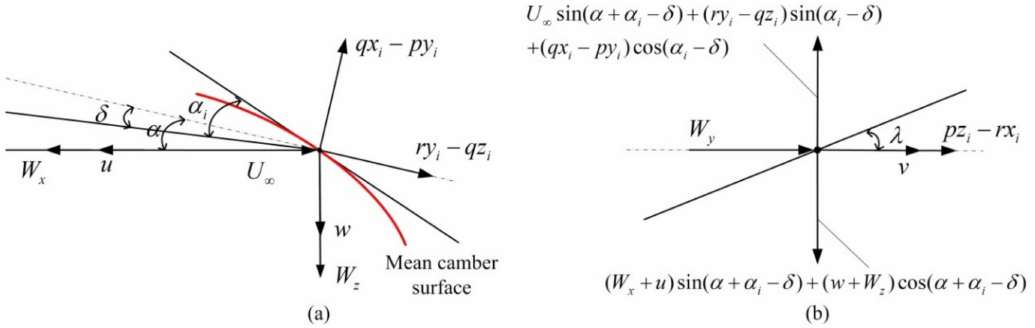
Figure 4. ( a ) Boundary condition decomposition along the wing chord and ( b ) along the